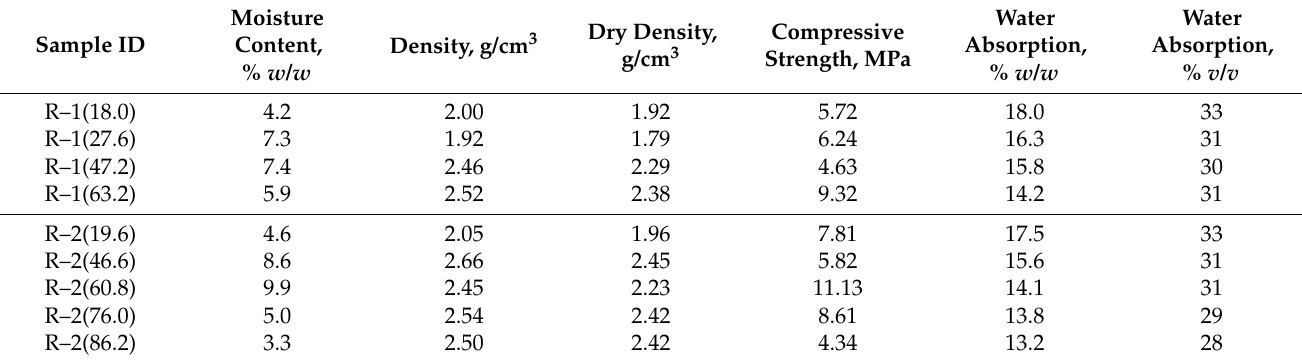
Table 2. Physical and mechanical parameters of volcanic tuff samples.